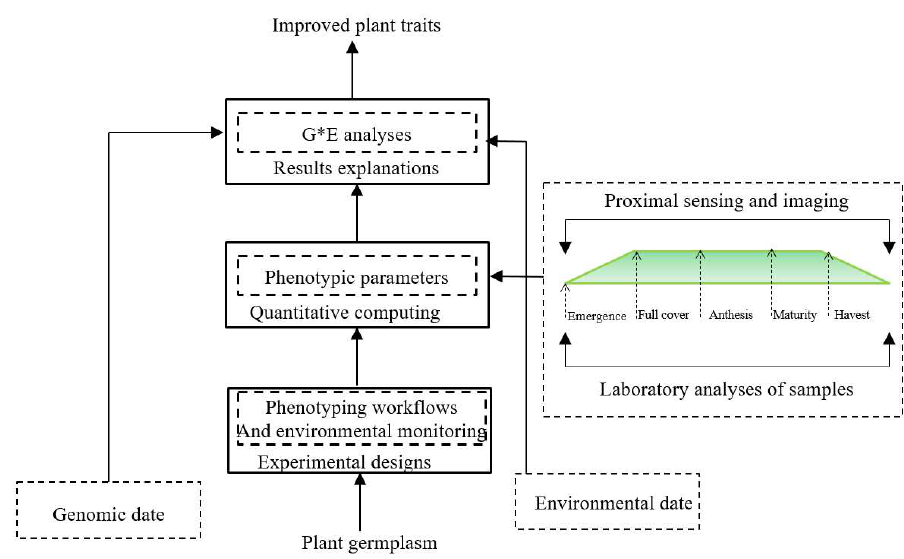
Figure 14. Method of five root orders [45].